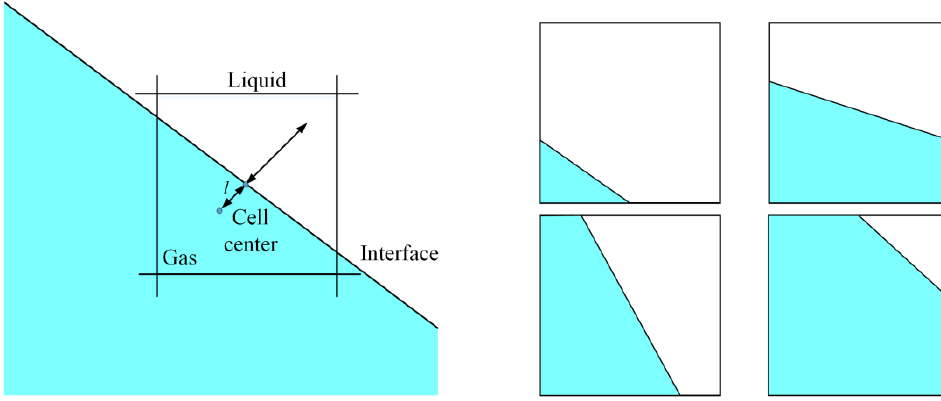
Figure 1. Typical interface form of piecewise linear interface reconstruction.